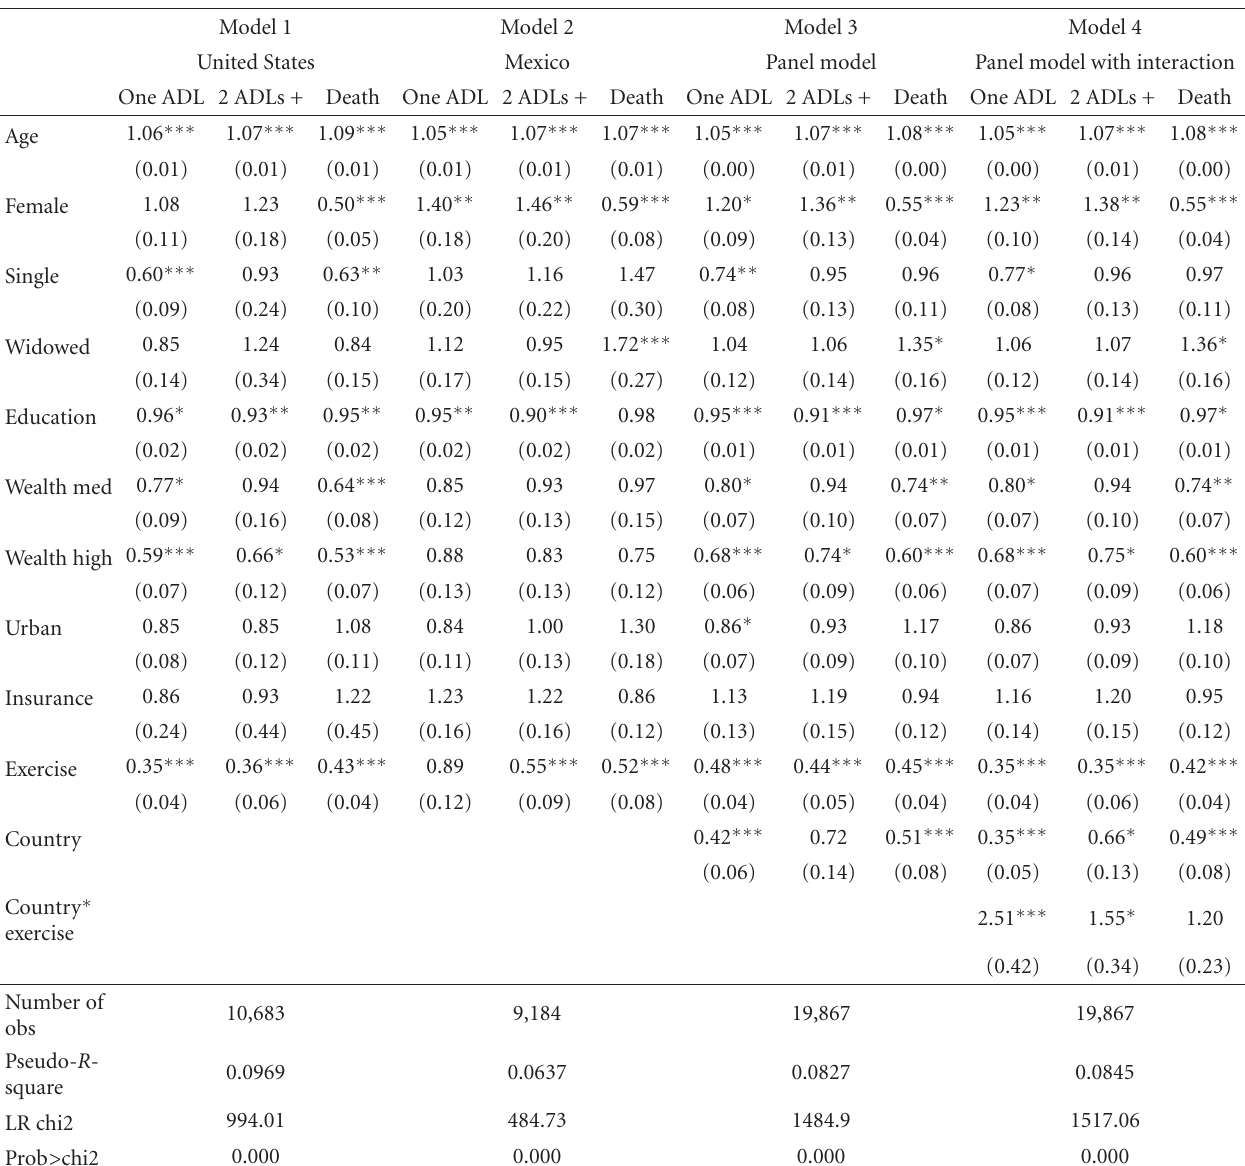
Table 4: Multinomial models for outcome at time 2 for persons without ADL limitations at Time 1, united states and